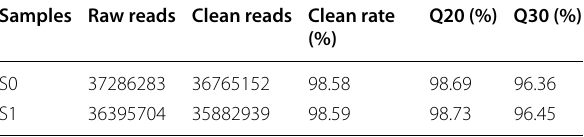
Table 2 Data filtering